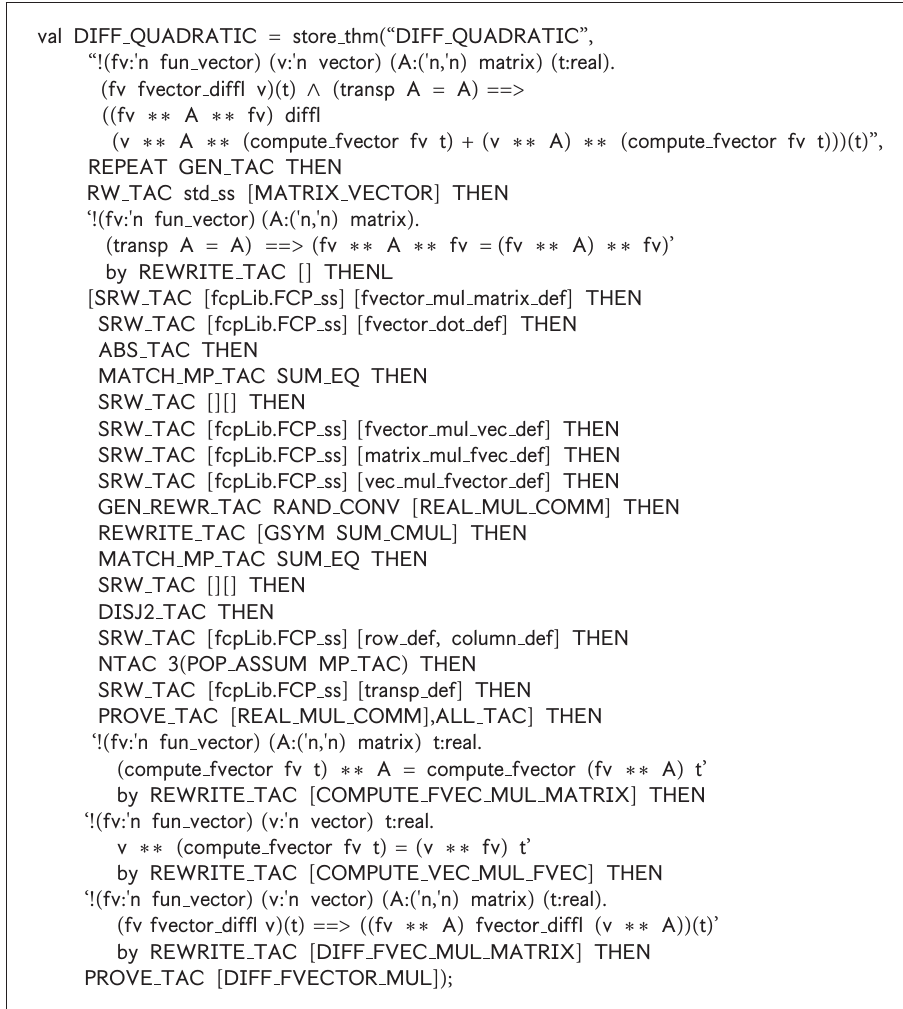
Algorithm 1: Formal proof of the quadratic function